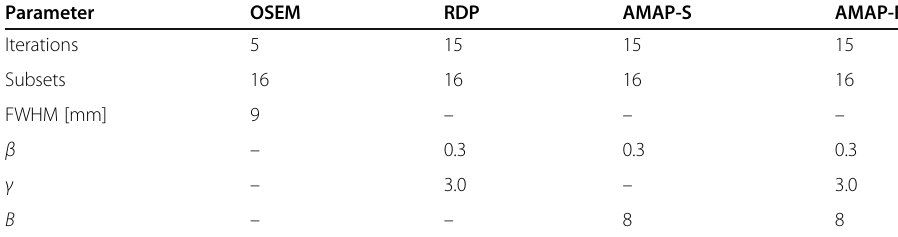
Table 1 Reconstruction